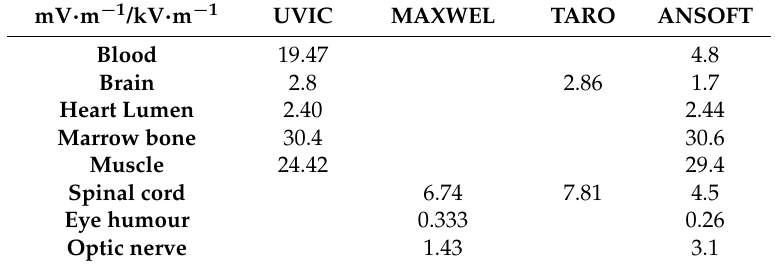
Table 2. Maximum induced electric field (mV · m − 1 ) per 1 kV · m − 1 of the pure vertical electric